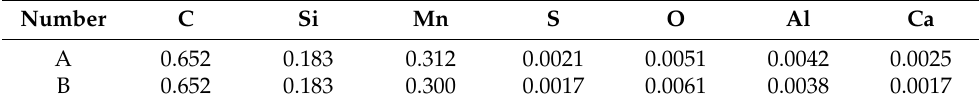
Table 2. Chemical compositions of steels used in different experiments (mass%).